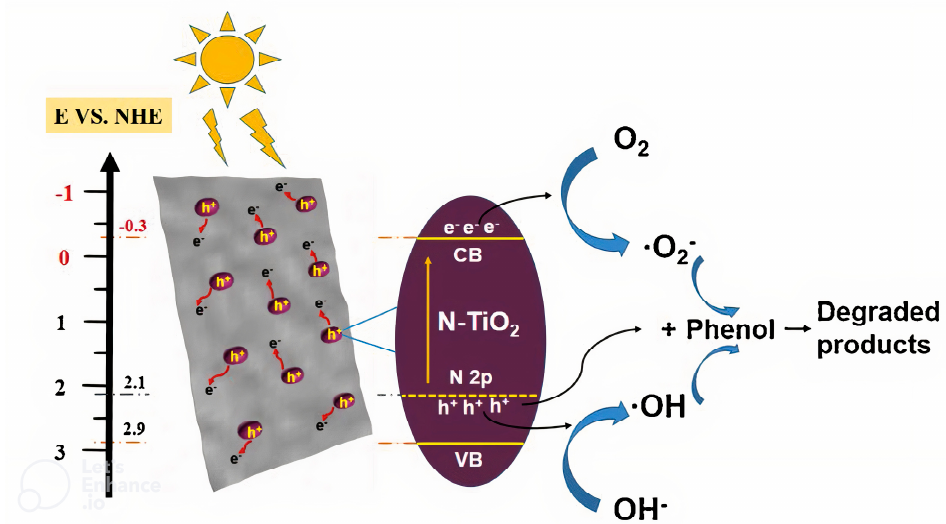
Figure 10. Photocatalytic phenol decomposition via N-TiO 2 @C [191].